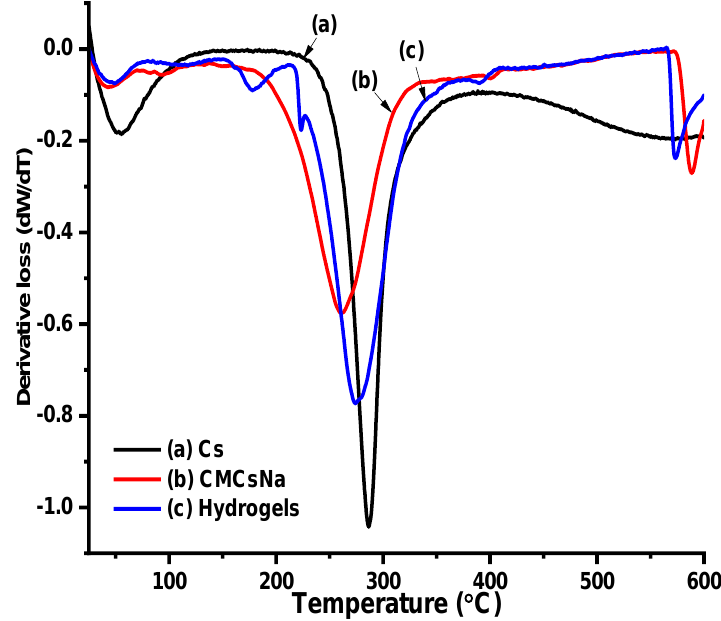
Figure 7. DTGA thermograms of (a) Cs, (b) CMCsNa, and (c) hydrogels. Both CMCs and Cs had two degradation stages in which, the first degradation stage accounted for water loss in CMCs and the hydrogels, which was slower than for Cs par- ticles (Figures 6 and 7). The second and third mass loss in the DTGA thermograms of the hydrogels was observed in the range between 175 – 300 °C. The onset degradation temper- ature and ash content for Cs was higher as compared to that of CMCs and the hydrogels.